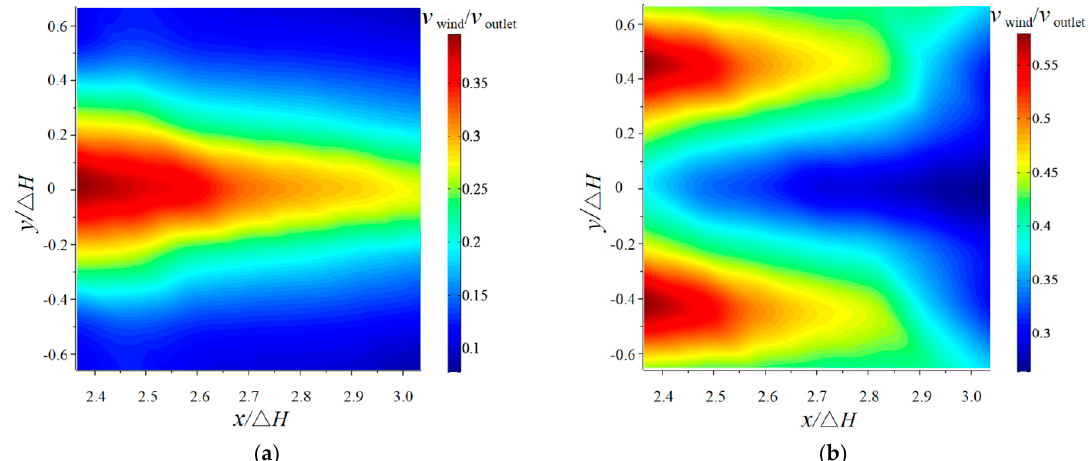
Figure 7. The nappe wind distribution of the two-dimensional plane ( z/ Δ H =0): (a) CB and (b) TB.